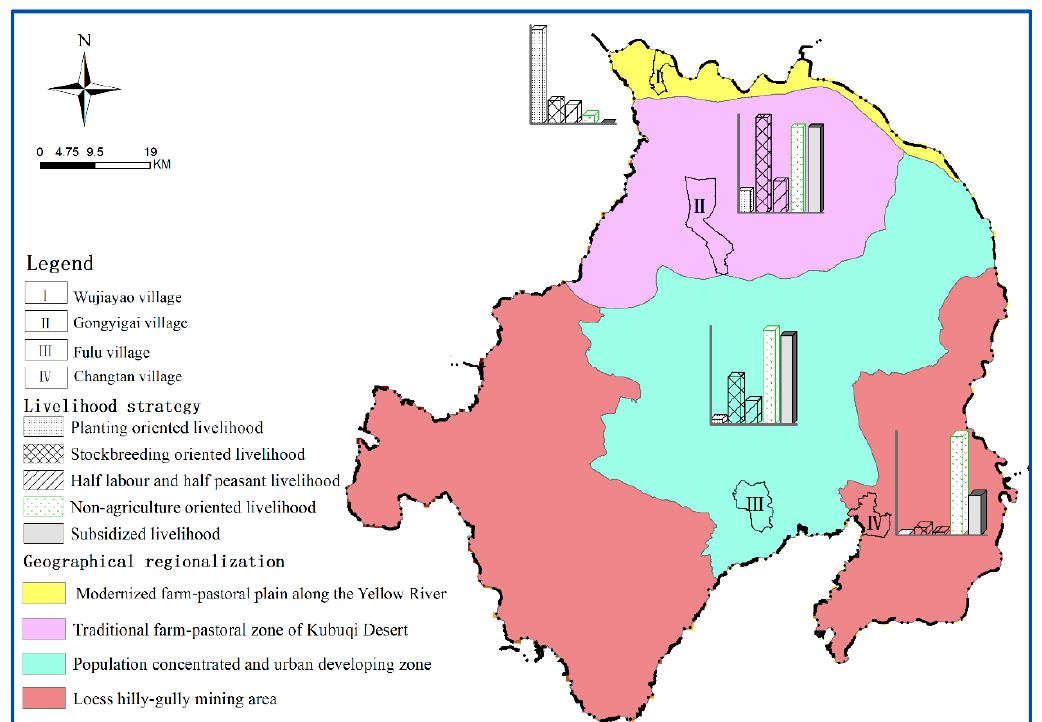
Figure 3. Geographical regionalization and livelihood patterns in Jungar Banner.